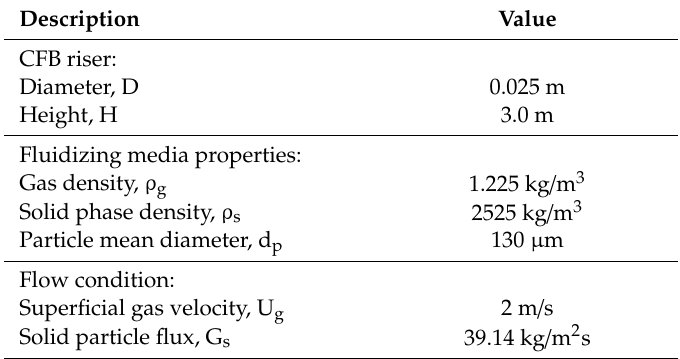
Figure 1. ( a ) Schematic diagram ( a ) CFB reactor ( b ) simplified 2D computational domain of CFB riser (1 —riser bed; 2—cyclone; 3—ball valves; 4—bubbling bed; 5—recirculation region; 6—loop-seal). Table 1. System geometry, gas and solid phase properties and flow